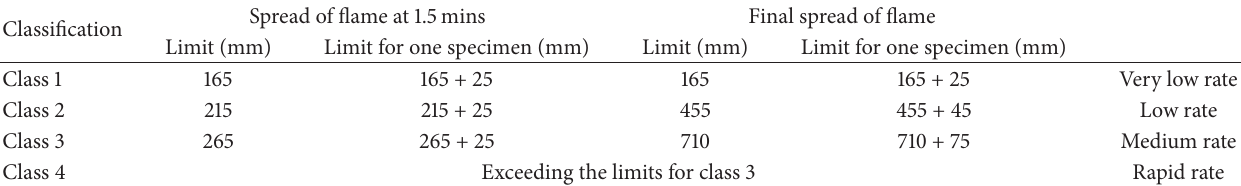
Table 1: Flame classification